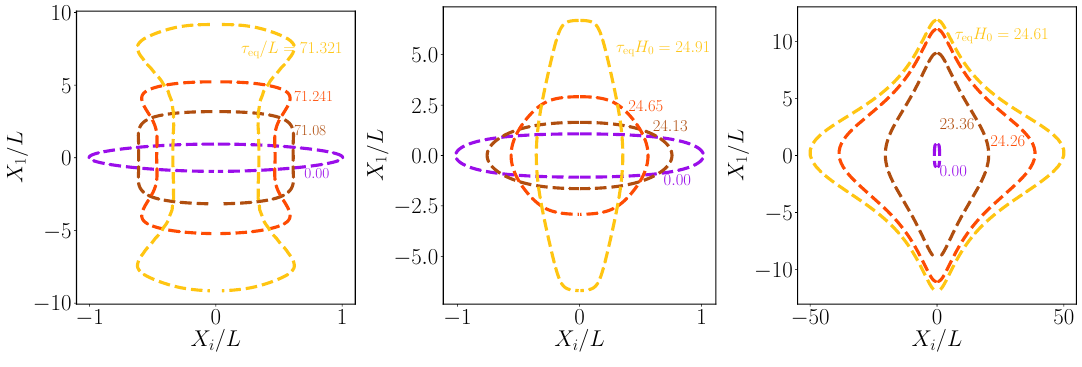
Figure 11 . Sample solutions on the large Hubble warped branch with p = q = 4 , Λ D = 1 , ( H ) = (1 . 3 × 10 − 5 , 435 . 23) (left), ( H 0 /M 4 , n (0 . 0075 , 402 . 11) (right) where recall n